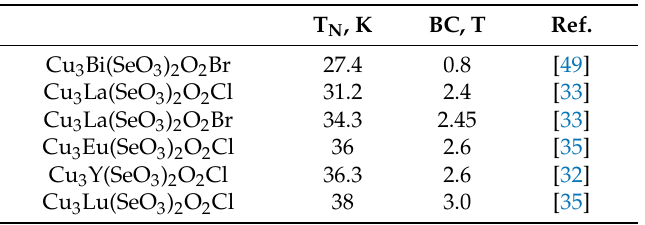
Table 2. N é el temperatures of antiferromagnetic ordering and metamagnetic transitions critical field values for Cu 3 M(SeO 3 ) 2 O 2 Cl (M = Y, La, Eu, Lu) and Cu 3 M(SeO 3 ) 2 O 2 Br (M = Bi,